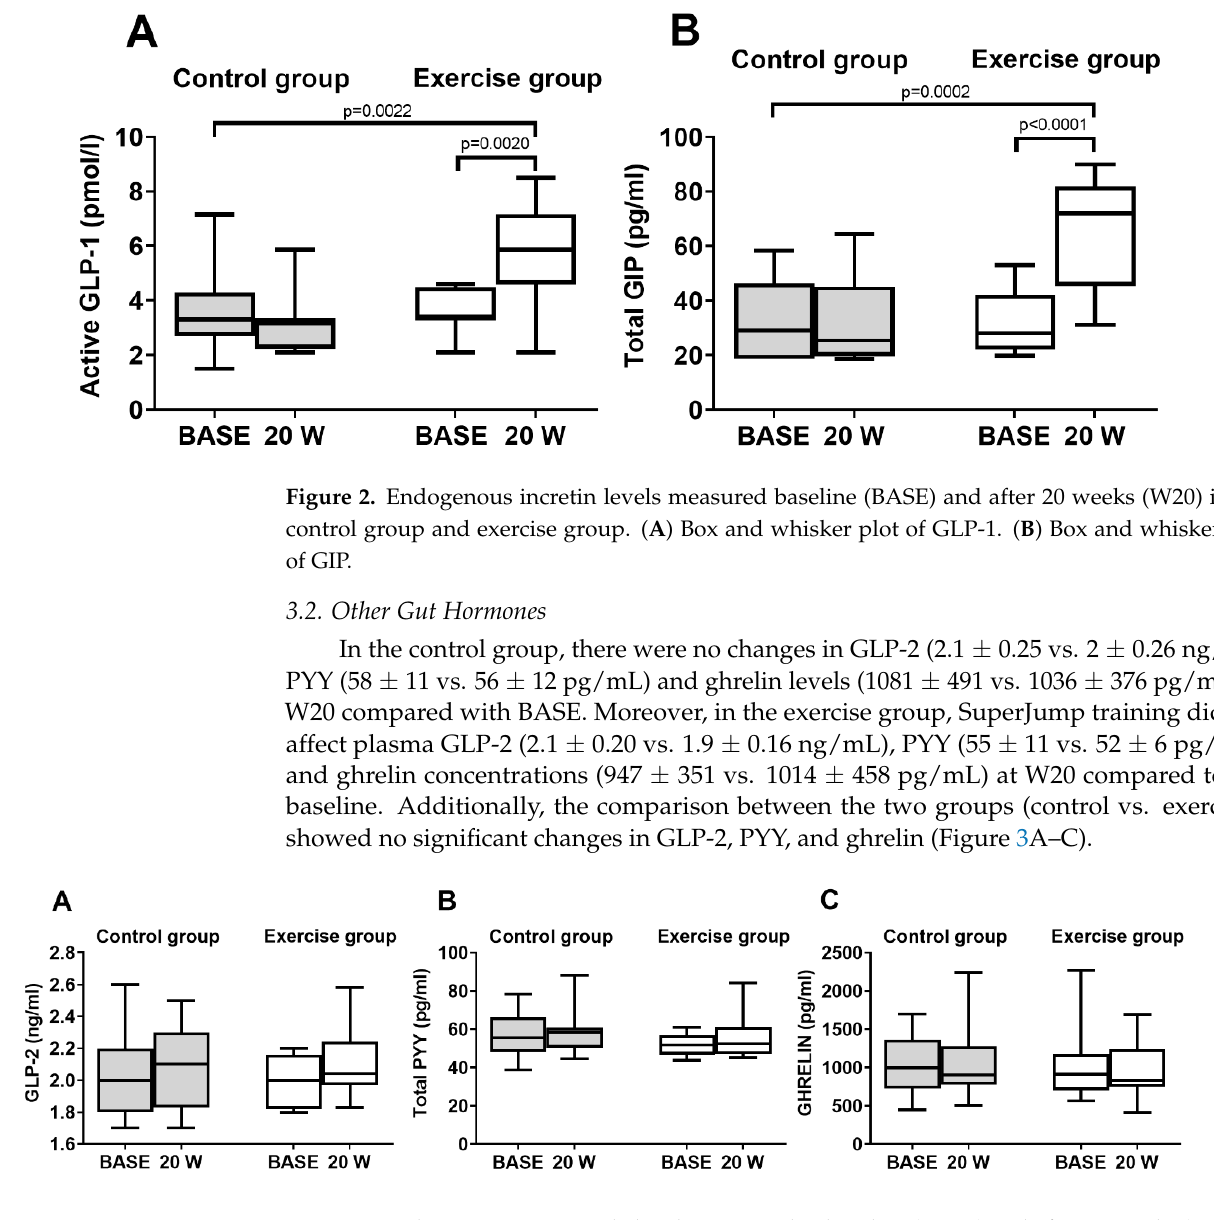
Figure 2. Endogenous incretin levels measured baseline (BASE) and after 20 weeks (W20) in the 201 control group and exercise group. ( A ) Box and whisker plot of GLP-1. ( B ) Box and whisker plot of 202 GIP.